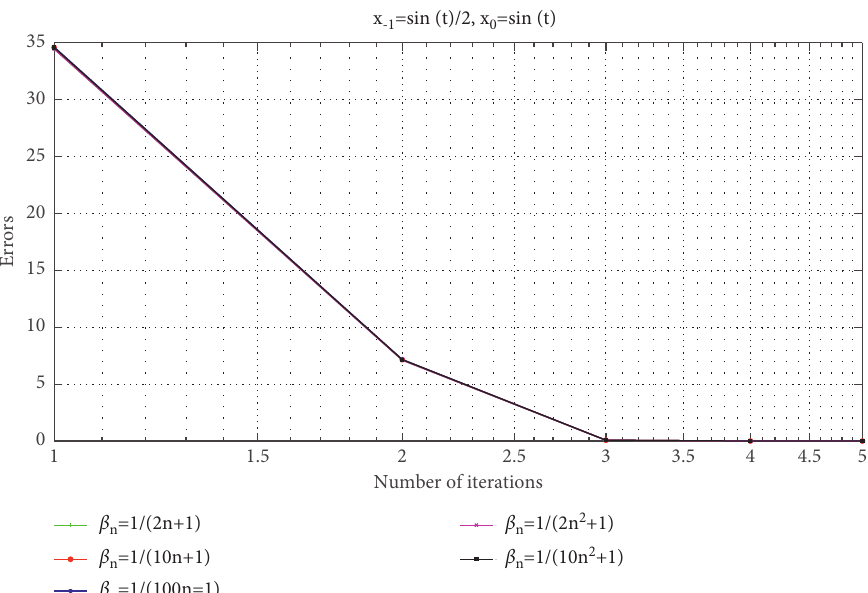
Figure 10: The Cauchy error plotting number of iterations for different parameters β